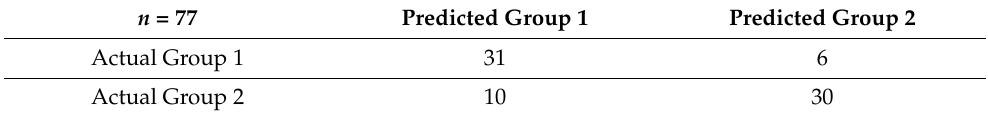
Table 7. Accuracy of decision trees.